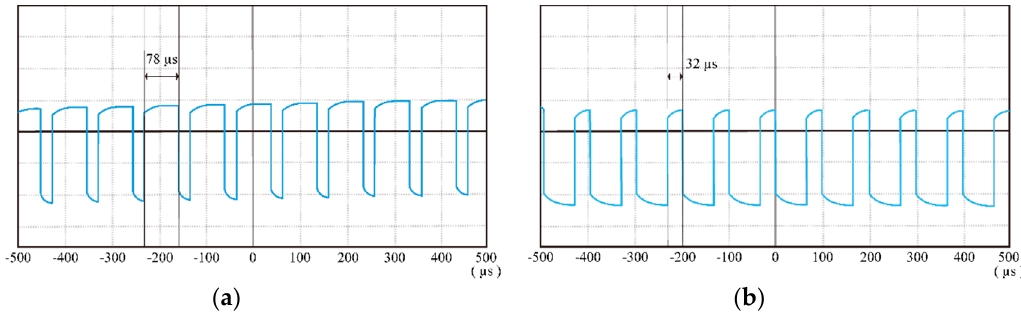
Figure 16. The execution times of: ( a ) traditional method, and ( b ) improved MPCC method.